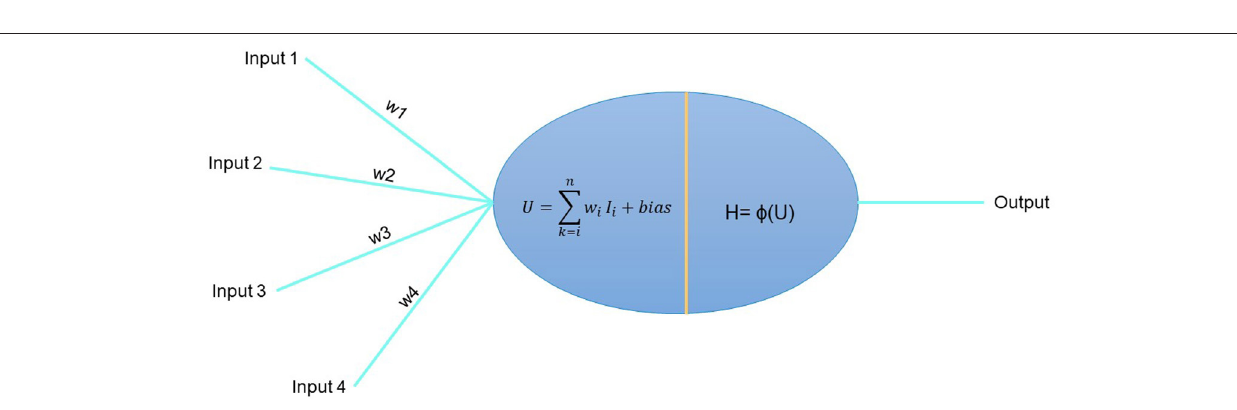
FIGURE 3 | Node structure of an